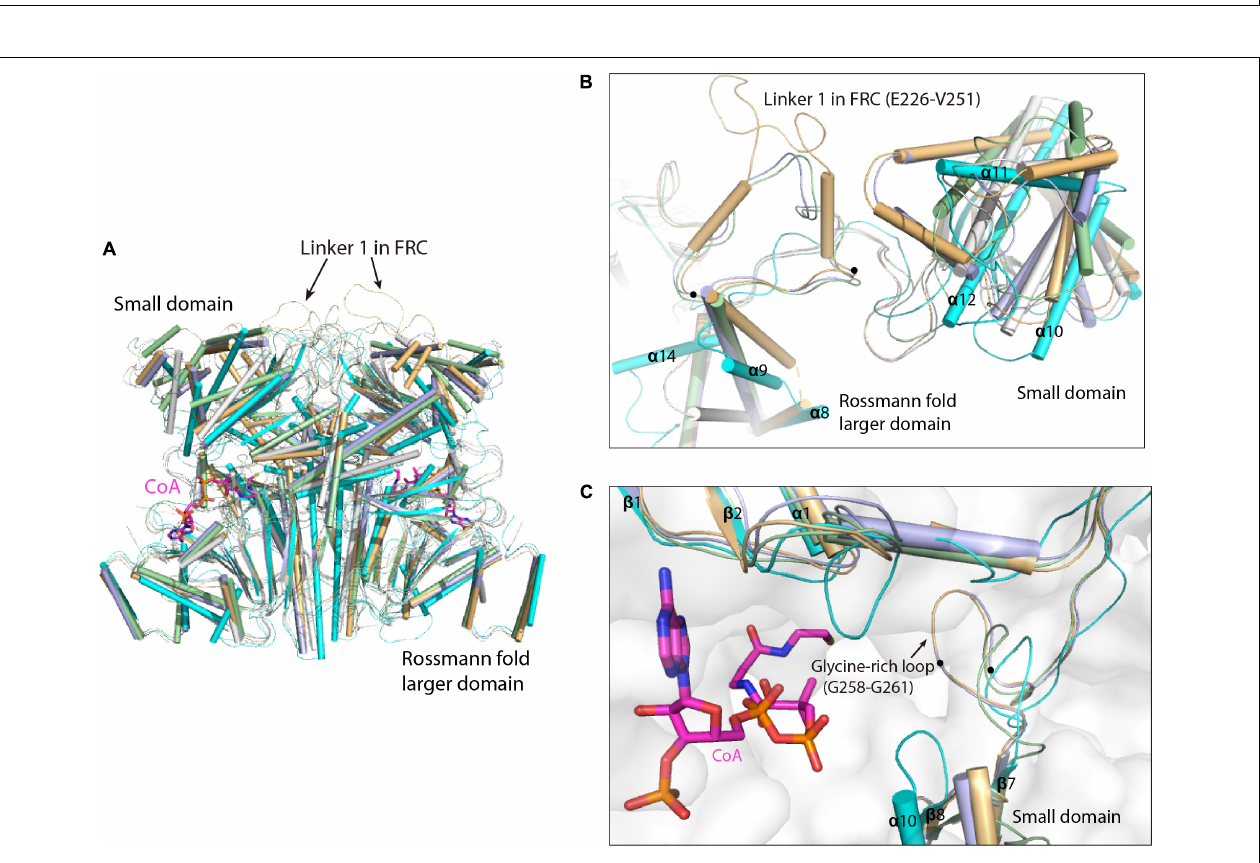
FIGURE 2 | Superimposition of R. castenholzii MCT dimer with that of the type III CoA-transferases. (A) Overall structure superimposition of MCT dimer with the dimers of formyl-CoA transferase from Oxalobacter formigenes (FRC, PDB ID: 2VJQ, yellow orange); formyl-CoA transferase from E. coli (YfdW, PDB ID: 1PT5, light blue); CoA transferase III from Mycobacterium tuberculosis (Rv3272, PDB ID: 5YIT, white); formyl-CoA: oxalate-CoA transferase from Acetobacter aceti (FCOCT, PDB ID: 3UBM, light green). The structures are aligned at the Rossman fold larger domain. The linker 1 in FRC is indicated with arrows. The CoA molecules bound in FCOCT are shown as stick models in magenta. (B) Comparison of the small domains and linker 1 loops in MCT and some type III CoA-transferases. The linker 1 loop in FRC is indicated with dots at the two ends of the loop and labeled. (C) Comparison of the substrate binding pocket of MCT with that of the type III CoA-transferases. The glycine-rich loop in FRC is indicated with dots at the two ends of the loop and labeled.